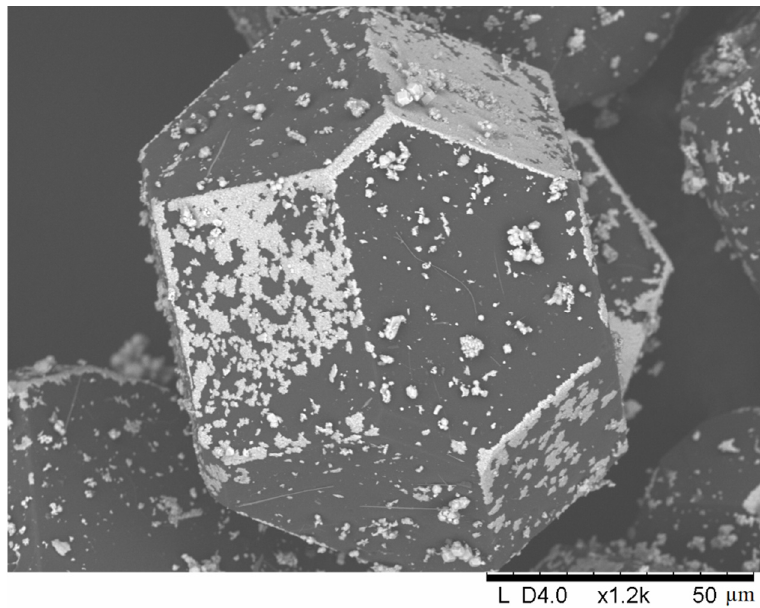
Figure 5. XRD pattern of the partially oxidized Mo powder.